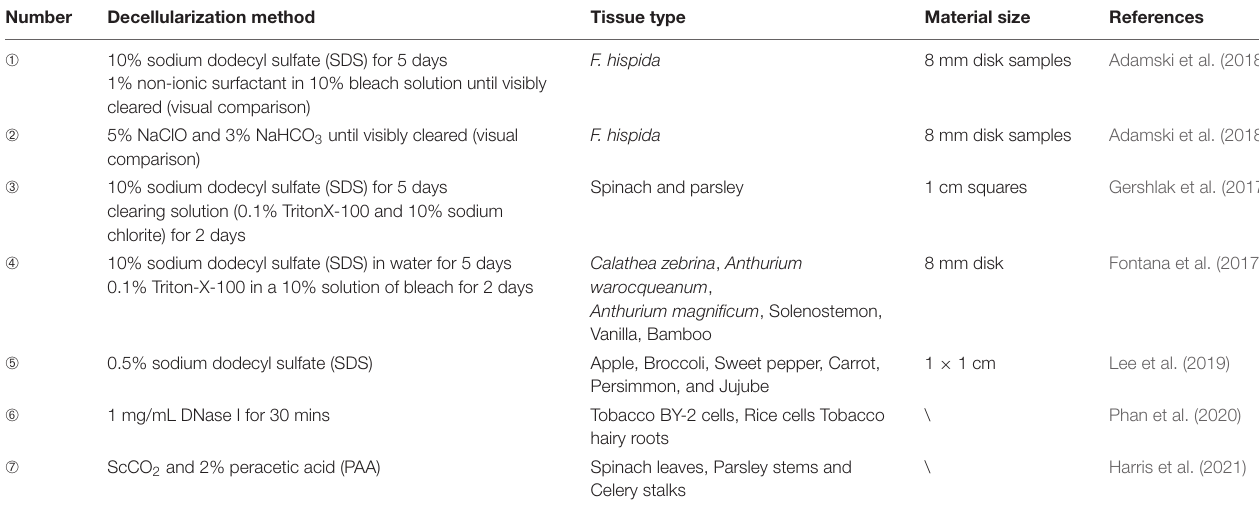
TABLE 1 | Representative protocols used for plant decellularization.